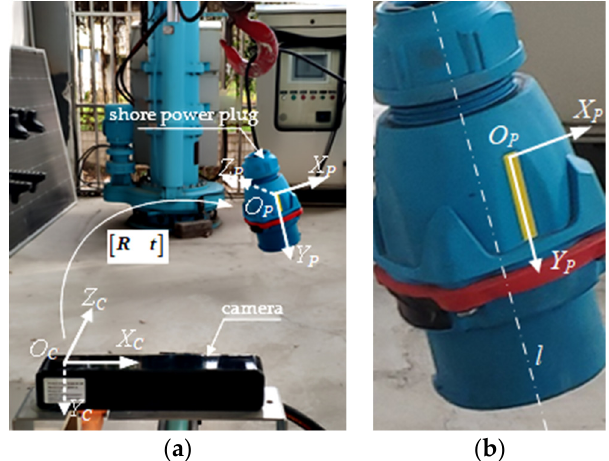
Figure 2. Camera and beacon co-ordinate system. ( a ) Relation between camera and beacon coordinate sys − tem. ( b ) Definition of the beacon coordinate sys − tem.